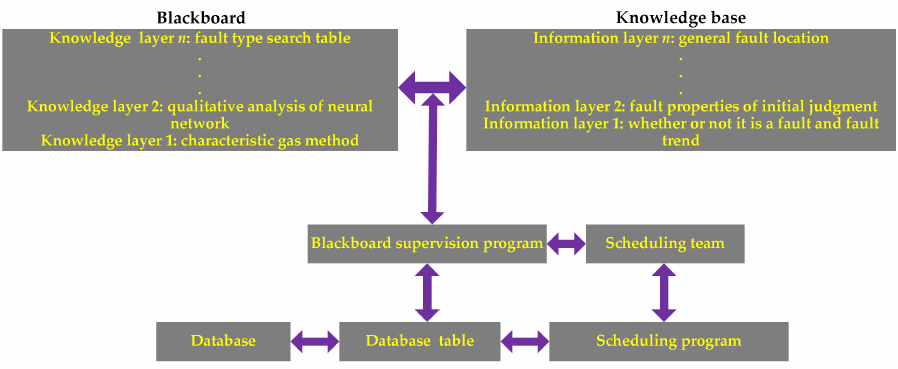
Figure 3. The blackboard model structure for transformer insulation fault